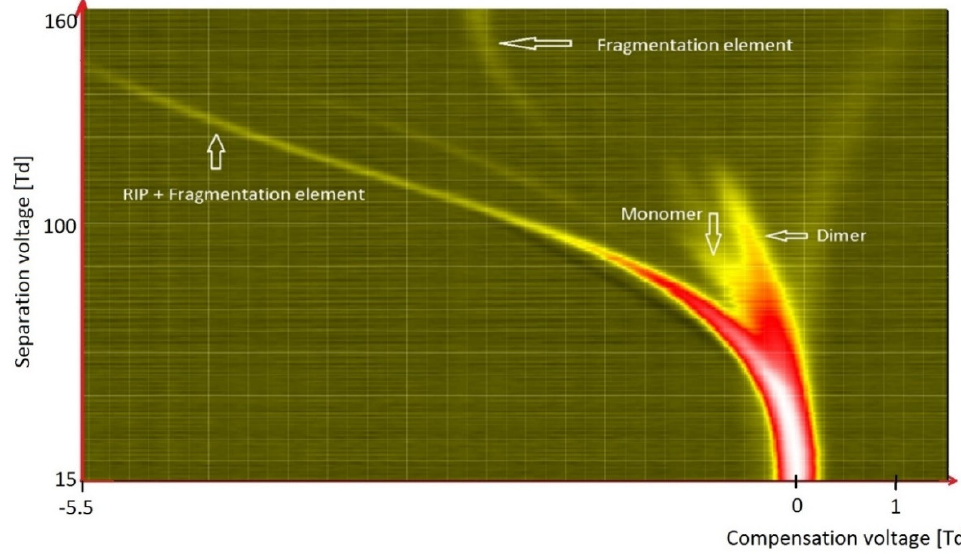
Figure 8. DMS spectrogram of ethanol, with identification of basic peaks.